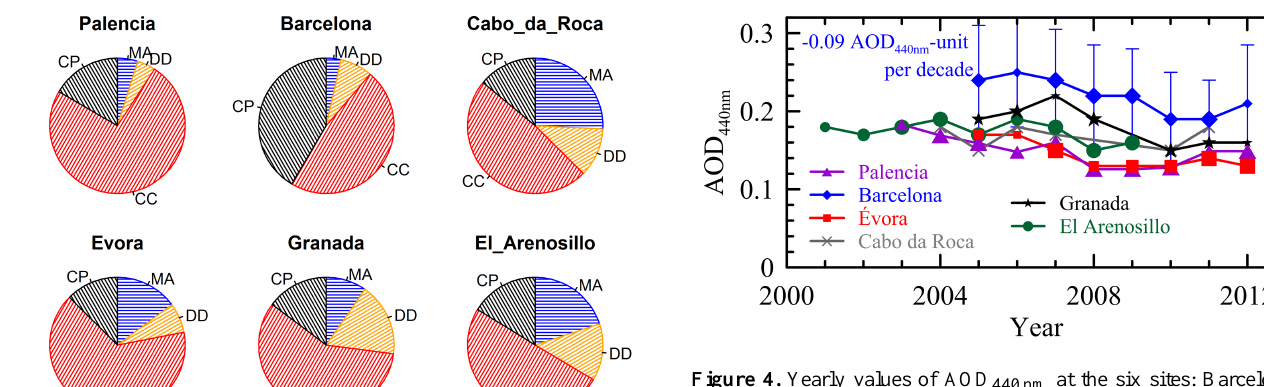
Figure 4. Yearly values of AOD 440nm at the six sites: Barcelona (blue diamonds), Palencia (purple triangles), Évora (red squares), Cabo da Roca (grey crosses), Granada (black stars), and El Arenosillo (green circles). The text points out the statistically signif- icant trend obtained. Vertical bars indicate the standard deviation of each yearly value at the Barcelona station. The larger the symbols, the larger amount of data points that year (e.g., the smallest sym- bols indicate cases between 100 and 150 points, while the largest symbols show years with >250